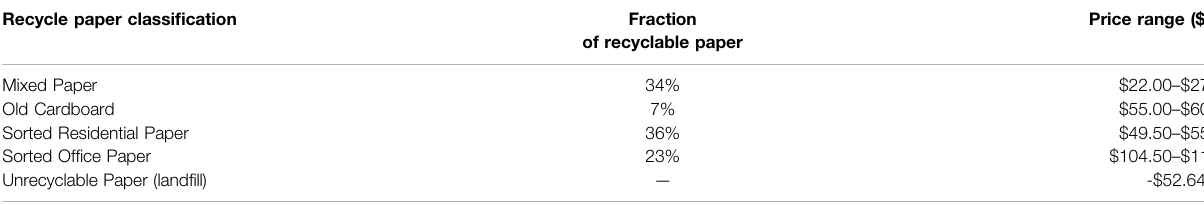
TABLE 4 | Prices of recycle paper in the US Midwest in USD (2020) (Recycling Today, 2020). Recycle paper classi fi cation